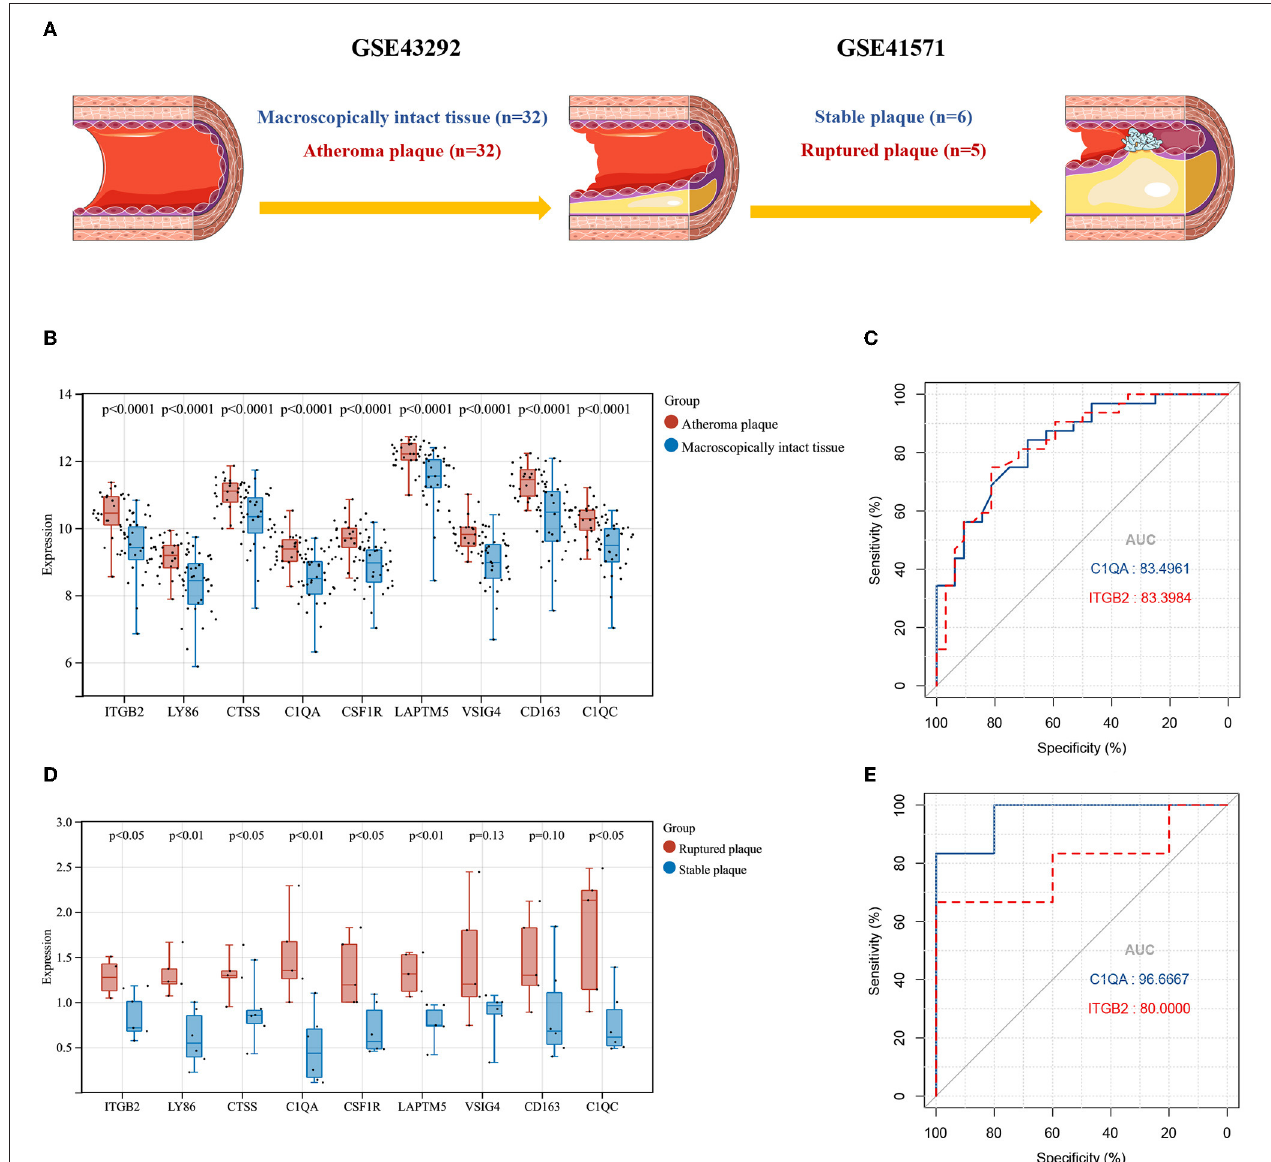
FIGURE 6 | (A) The detailed information and the pathophysiological relations of validation datasets GSE43292 and GSE41571. (B) The expression levels of the cluster genes in GSE43292and analyzed by student’s t -test. (C) ROC curves for C1QA and ITGB2 in GSE43292. (D) The expression levels of the cluster genes in GSE41571 and analyzed by student’s t test. (E) ROC curves for C1QA and ITGB2 in GSE41571. AUC, area under the curve; ROC, receiver operating